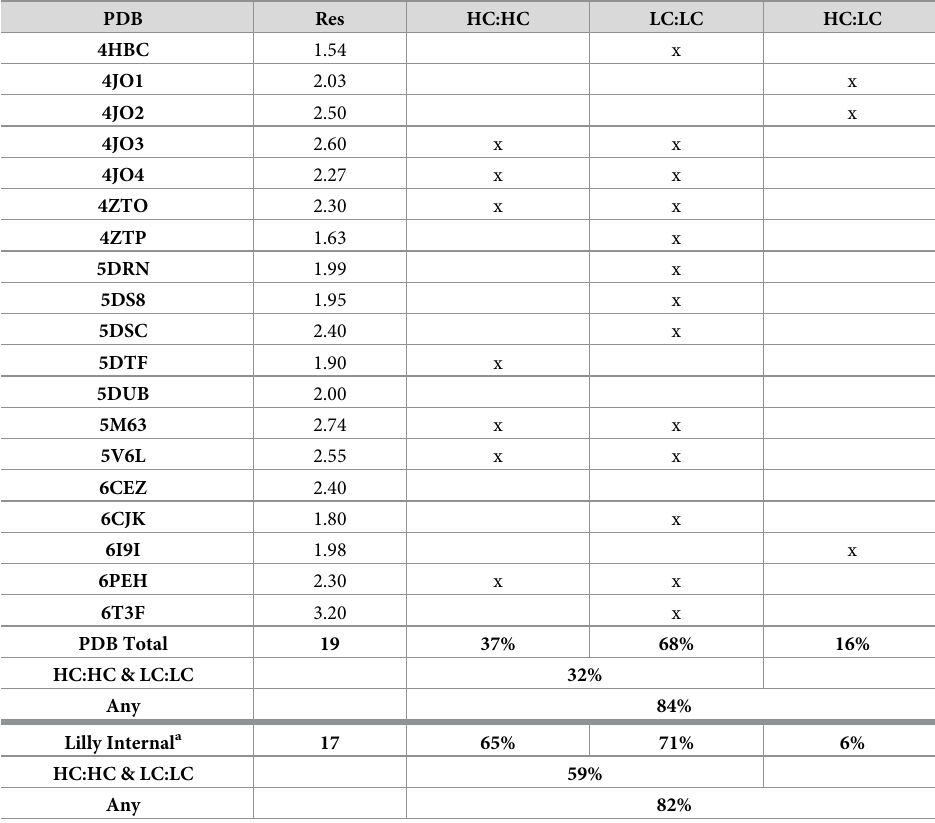
Table 1. G-strand beta sheet crystal packing of rabbit Fab and Fab complex structures. PDB Res HC:HC LC:LC HC:LC 4HBC 1.54 x 4JO1 2.03 x 4JO2 2.50 x 4JO3 2.60 x x 4JO4 2.27 x x 4ZTO 2.30 x x 4ZTP 1.63 x 5DRN 1.99 x 5DS8 1.95 x 5DSC 2.40 x 5DTF 1.90 x 5DUB 2.00 5M63 2.74 x x 5V6L 2.55 x x 6CEZ 2.40 6CJK 1.80 x 6I9I 1.98 x 6PEH 2.30 x x 6T3F 3.20 x PDB Total 19 37% 68% 16% HC:HC & LC:LC 32% Any 84% Lilly Internal a 17 65% 71% 6% HC:HC & LC:LC 59% Any 82% Percentage of deposited PDB structures with either HC:HC, LC:LC or HC:LC G-strand beta sheet formation. Also indicated are percentage with both HC:HC and LC:LC packing as well as percentage of structures with any G-strand beta packing. Lilly internal statistics are listed below PDB statistics.